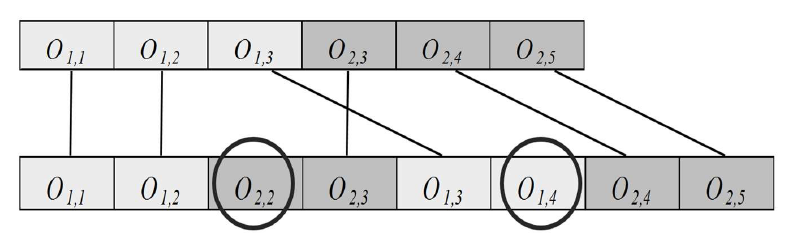
Fig. 6 Critical path